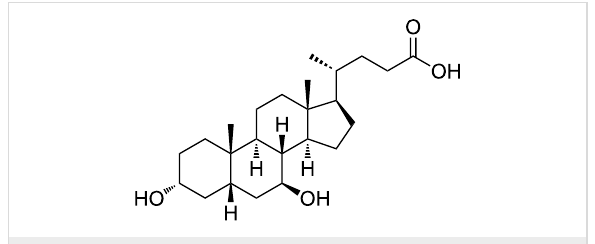
Figure 1: Chemical structure of UDCA.